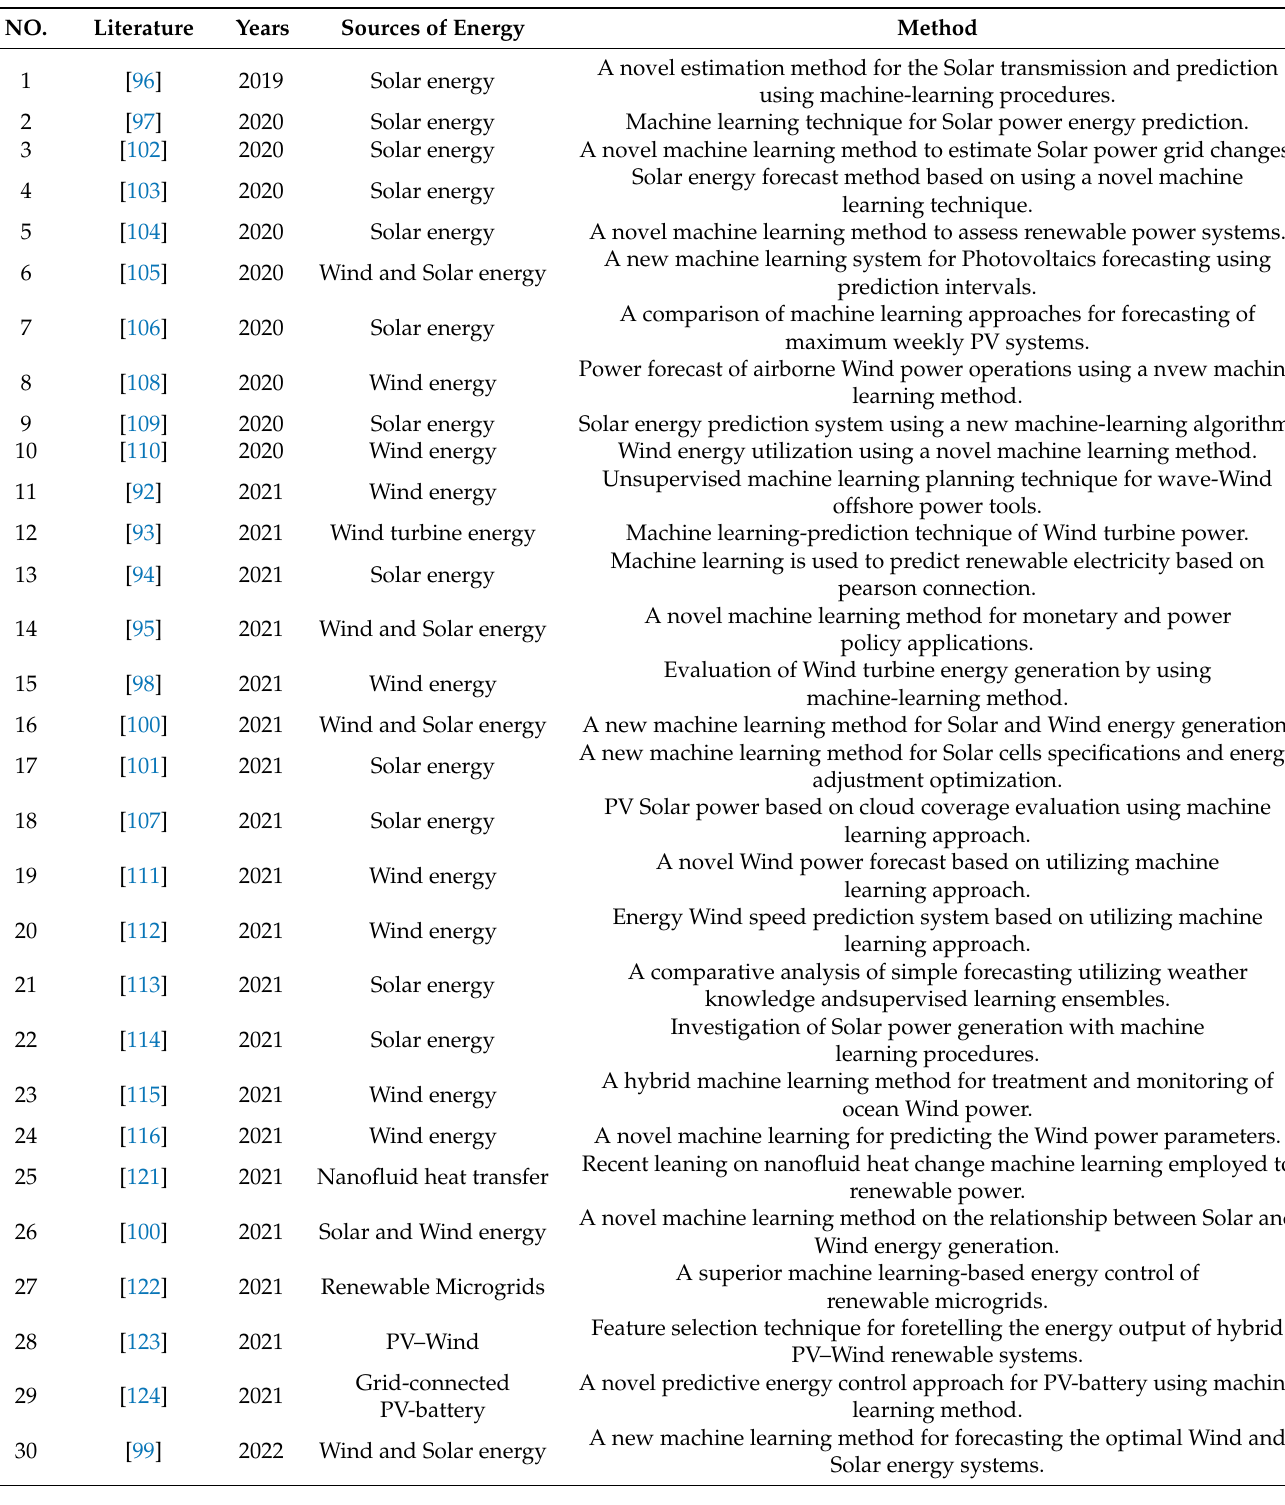
Table 4. An overview of applying machine learning techniques to renewable energy.